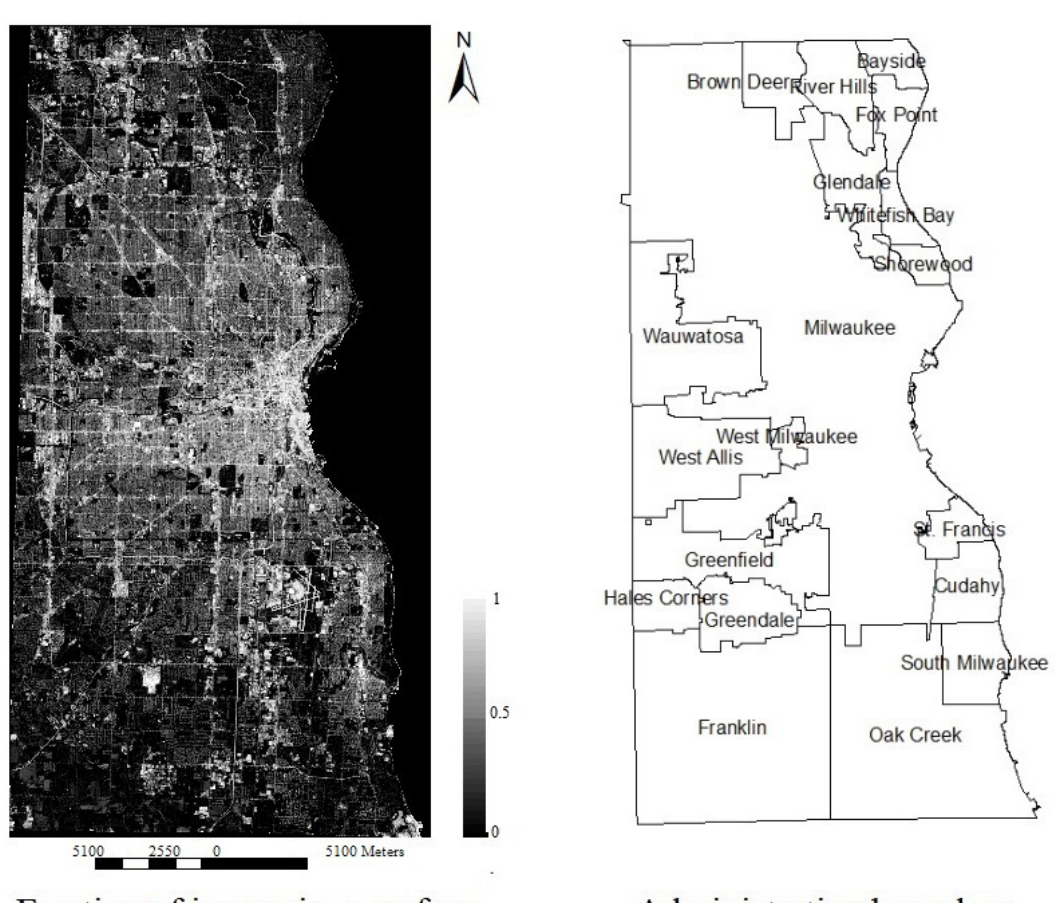
Figure 6. The fraction of impervious surface generated by the proposed statistical method-based spectral mixture analysis (SMA).